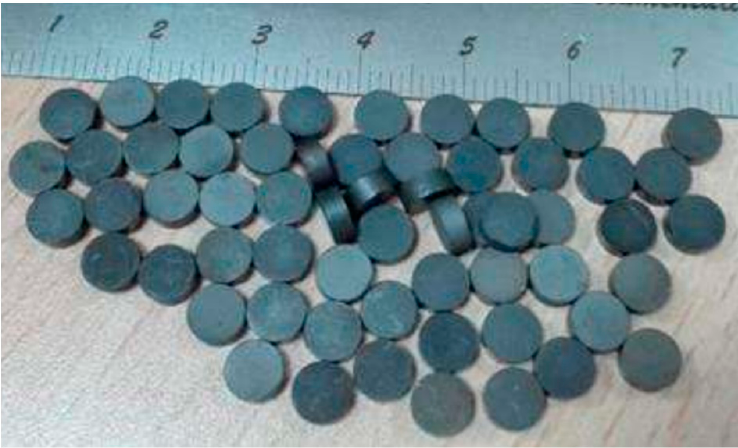
Figure 1. Sintered SiC samples. All the laser treated samples had a diameter of 5 mm and 2 mm in